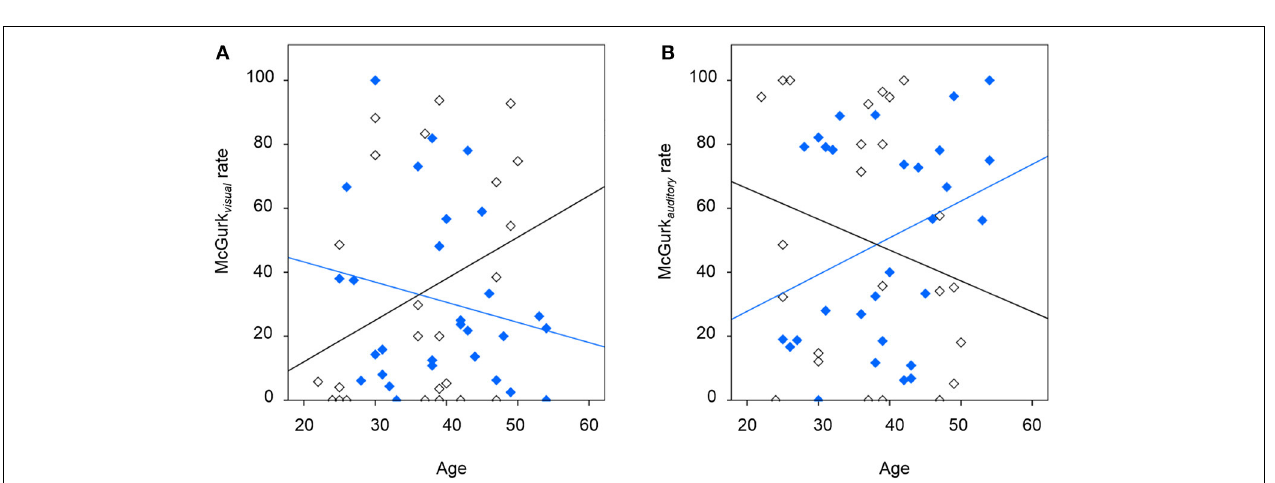
FIGURE 4 | The relationship between McGurk non-illusory perception and age, showing (A) findings for the McGurk visual rate for the schizophrenia group (in blue; R 2 of best-fit line: 0.035) and the significant relationship for healthy individuals following placebo (in